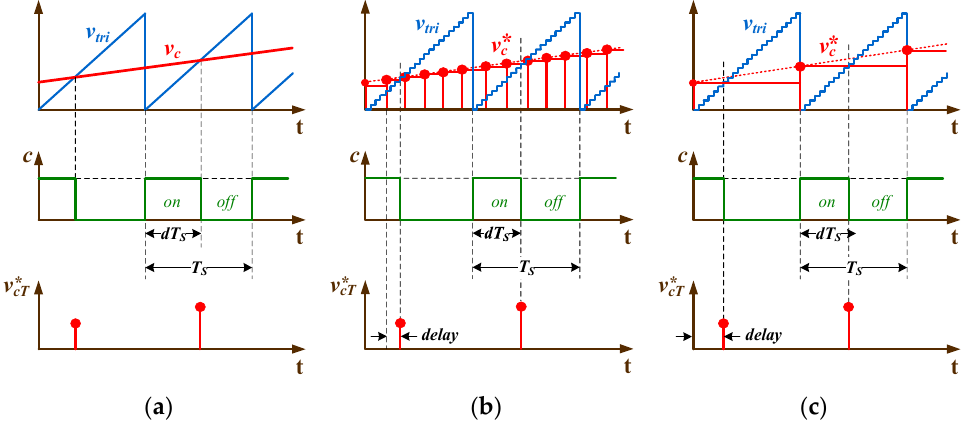
Figure 3. PWM modulator with trailing edge sawtooth carrier signal. ( a ) Natural sampling, ( b ) double sampling of the control signal, and ( c ) sampling of the control signal at the beginning of each switching period.